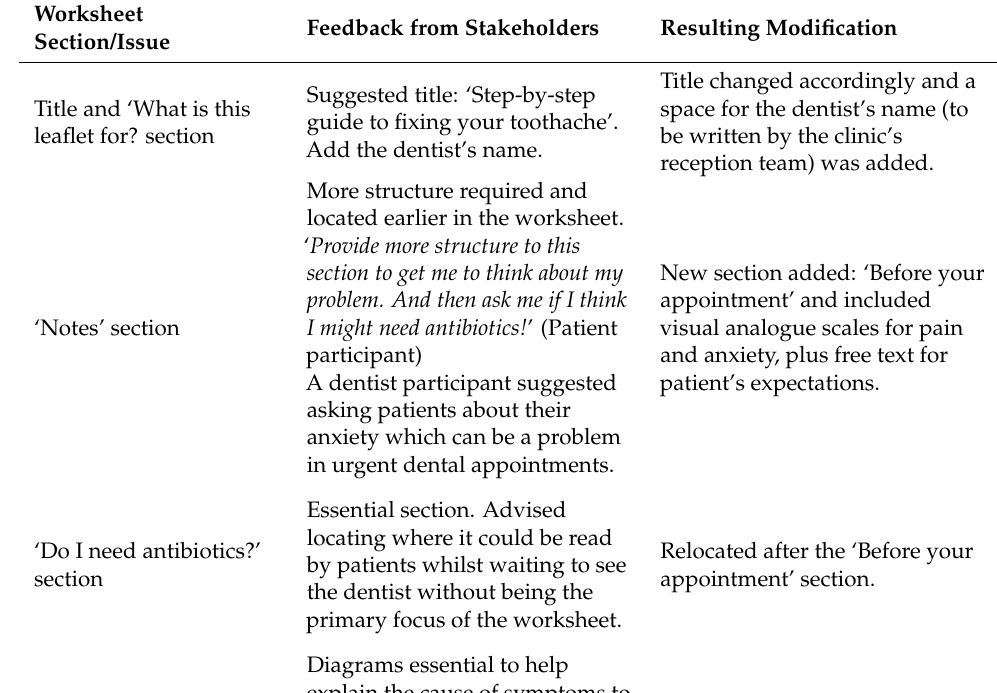
Table 2. Details of feedback from the stakeholders and resulting modifications made to the draft